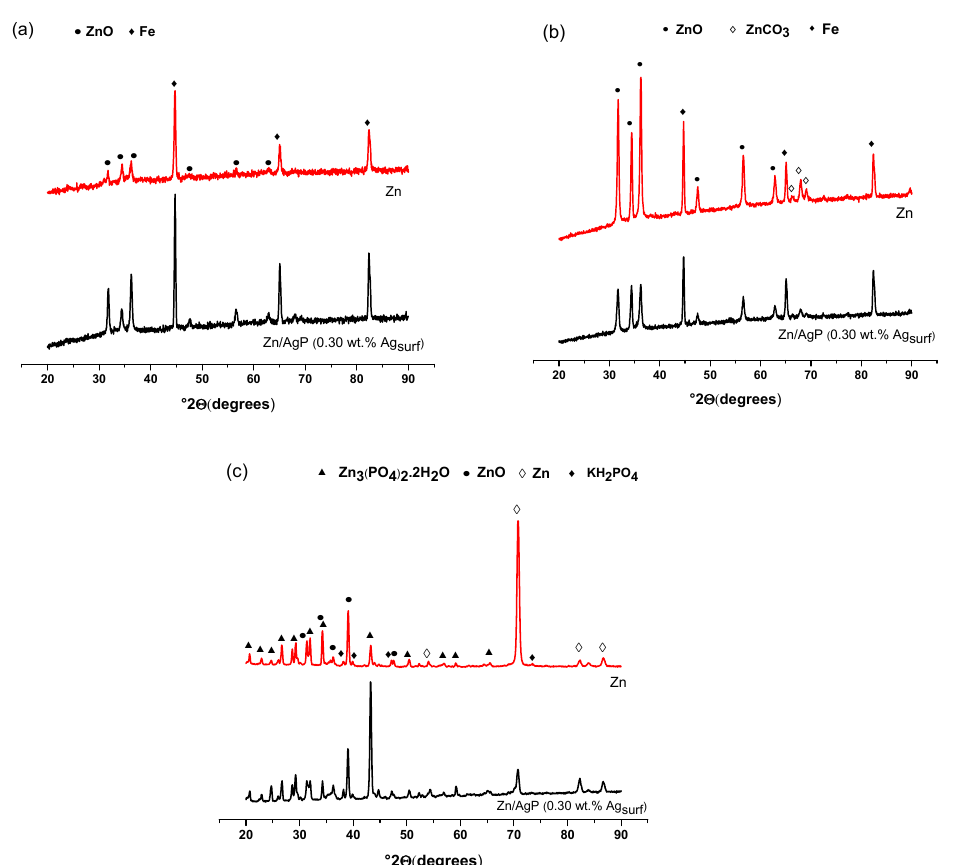
Figure 8. Normalized XRD patterns of Zn coatings and Zn / AgP (0.30 wt.% Ag) composite coatings obtained after 40 days of immersion at 37 ◦ C in ( a ) Hank’s solution, ( b ) Ringer’s solution and ( c ) PBS. Zn (JCPDS 04-0831), ZnO (JCPDS 36-1451), Zn 3 (PO 4 ) 2 · 2H 2 O (JCPDS 041-0493), ZnCO 3 (JCPDS 08-0449), Fe (JCPDS 06-0696), KH 2 (PO 4 ) (JCPDS 01-527).